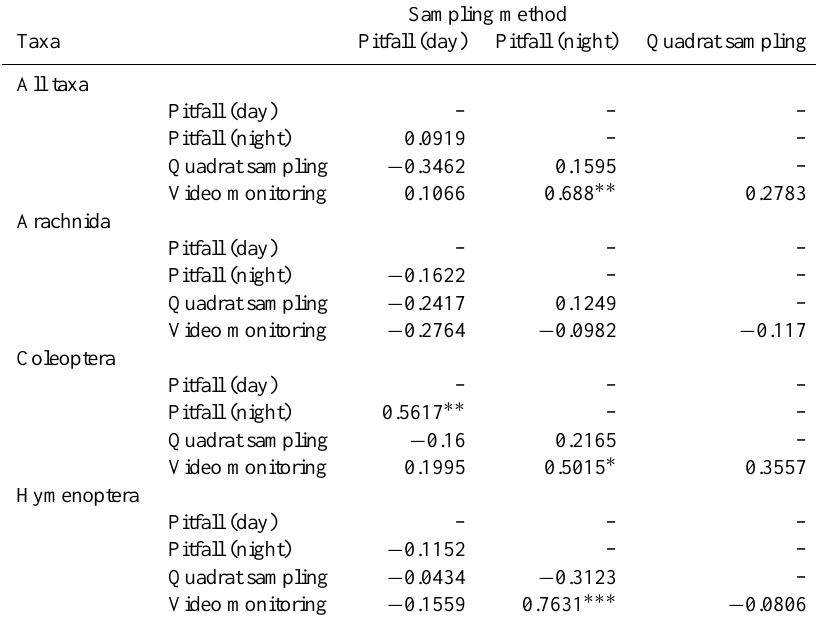
Table 3. Pearson correlation of number of individuals recorded with different